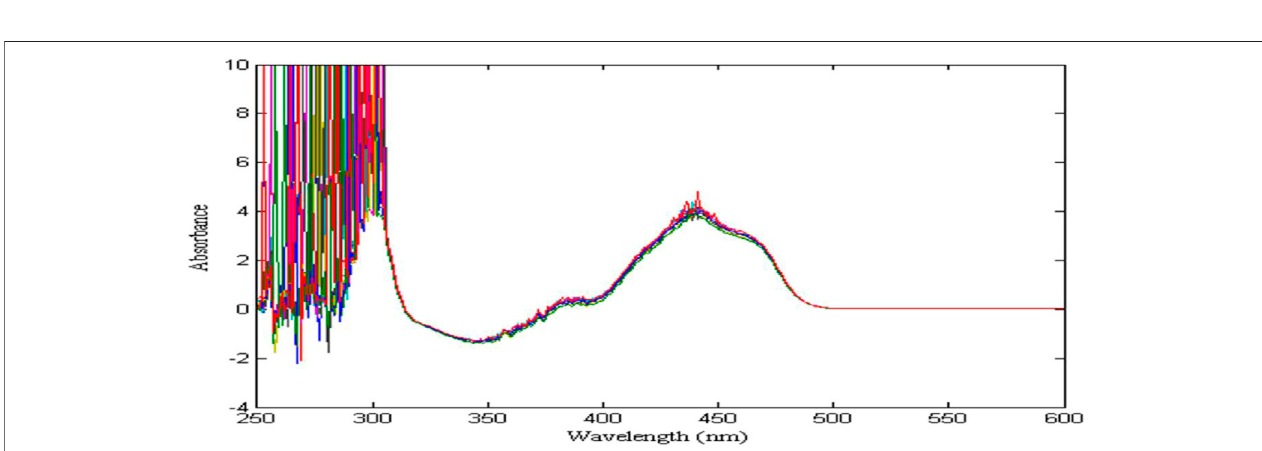
FIGURE 3 | The absorption spectral signal of zinc solution in the range of 20 – 30 g/L: Show results in wavelength range from 390 nm to 600 nm and Absorbance range from 0 to 6 (never below 0).